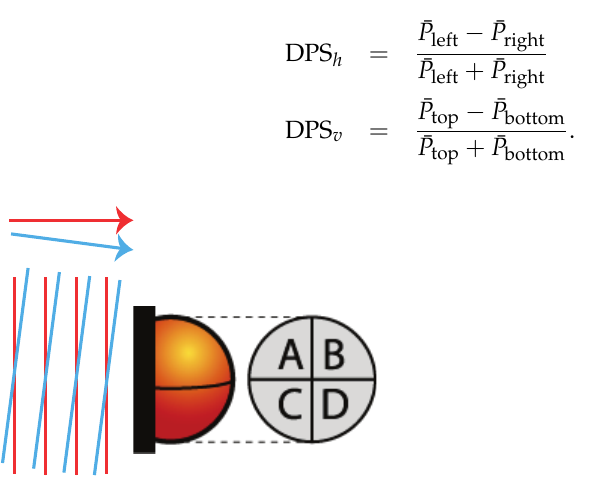
Figure 2. Principle of the differential wave-front sensing. Tilted beams cause phase-shifted beat notes on the different segments of a quadrant photo diode. The tilt angle can be determined by subtracting the phase of beat notes measured on the different photo diode